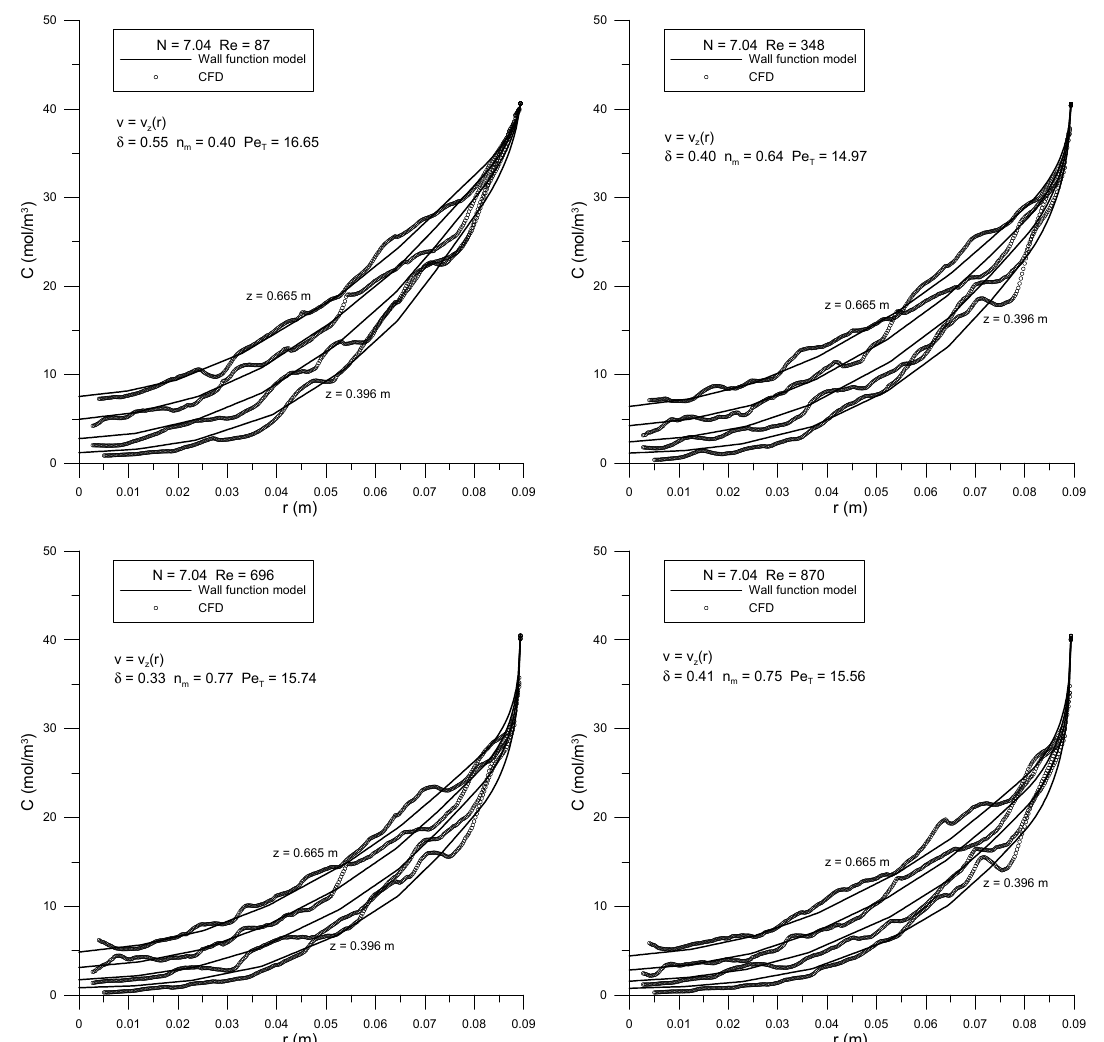
Figure 12. Results for three-parameter wall function model using D T ( r ) and v z ( r ) for the case N = 7.04, all four values of Re, each fitted to all four bed depths simultaneously.